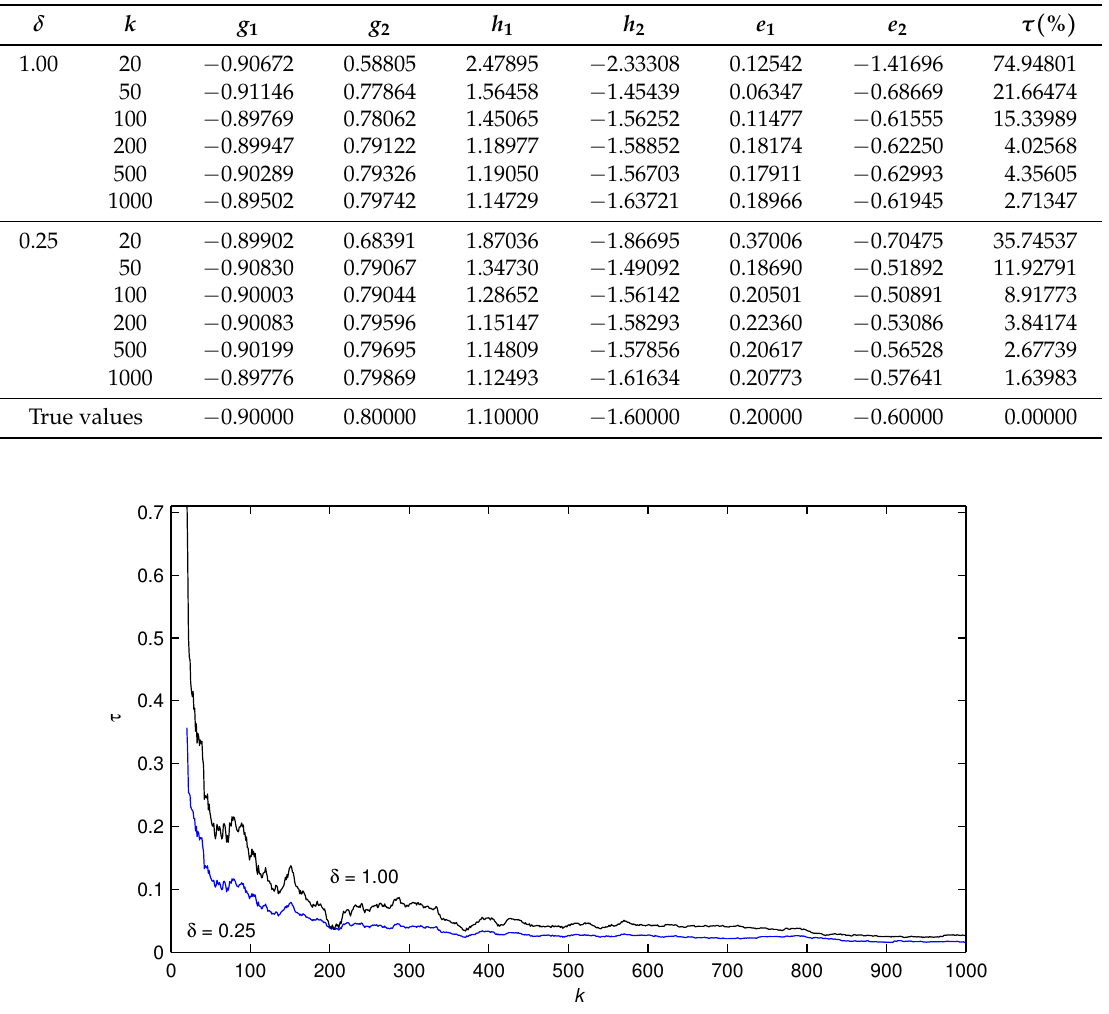
Figure 1. The estimation errors τ versus k with different noise variances for Example 1.